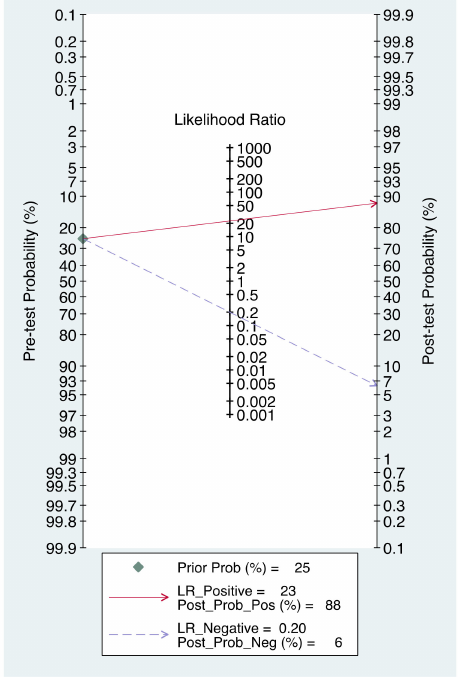
Figure 5. Fagan’s nomogram for likelihood ratios and the probability of preoperative PET/CT for detecting lymph node